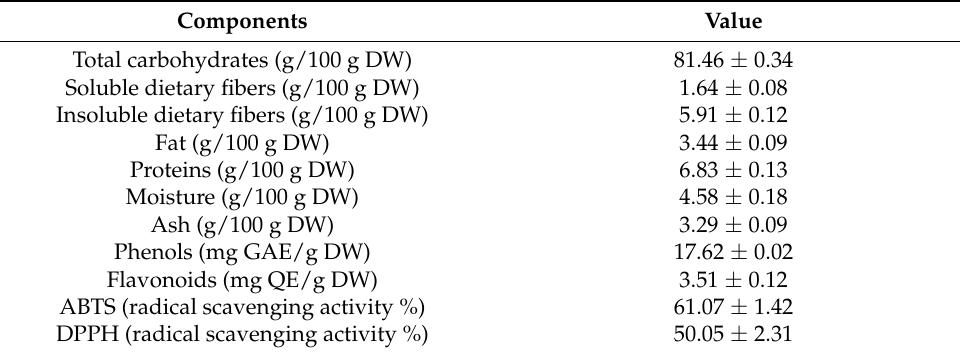
Table 1. Proximate composition and antioxidant properties of